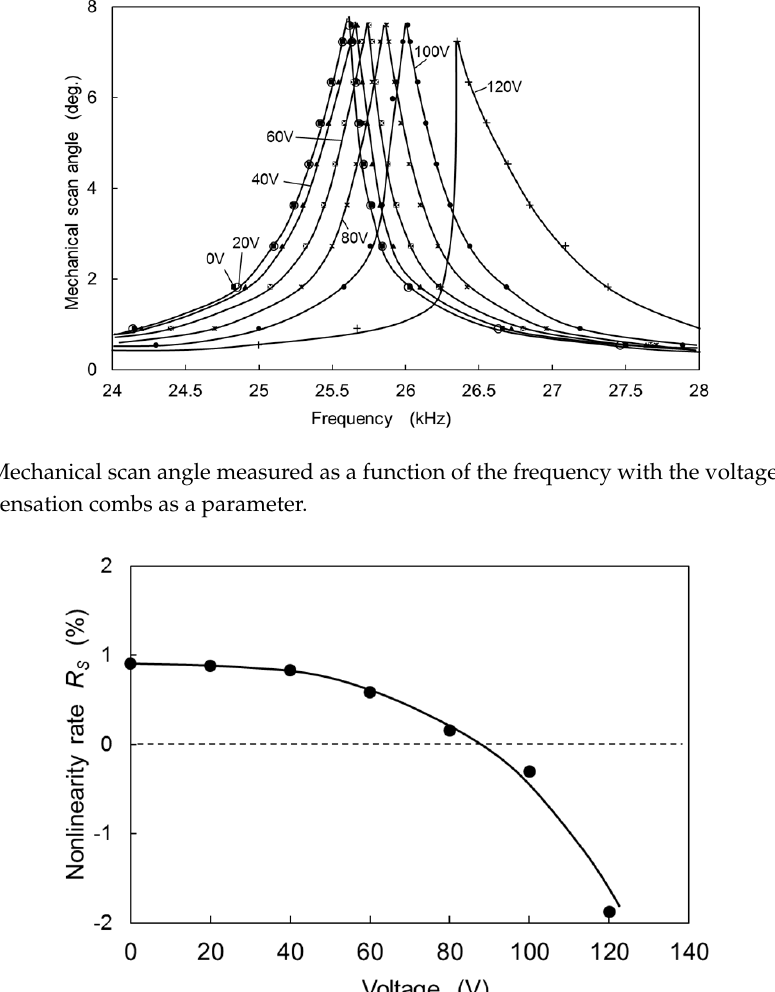
Figure 11. Nonlinear rate as a function of the voltage applied to the compensation combs.